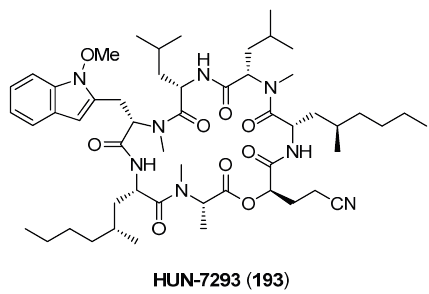
Figure 21. Structure of HUN-7293 ( 193 ).